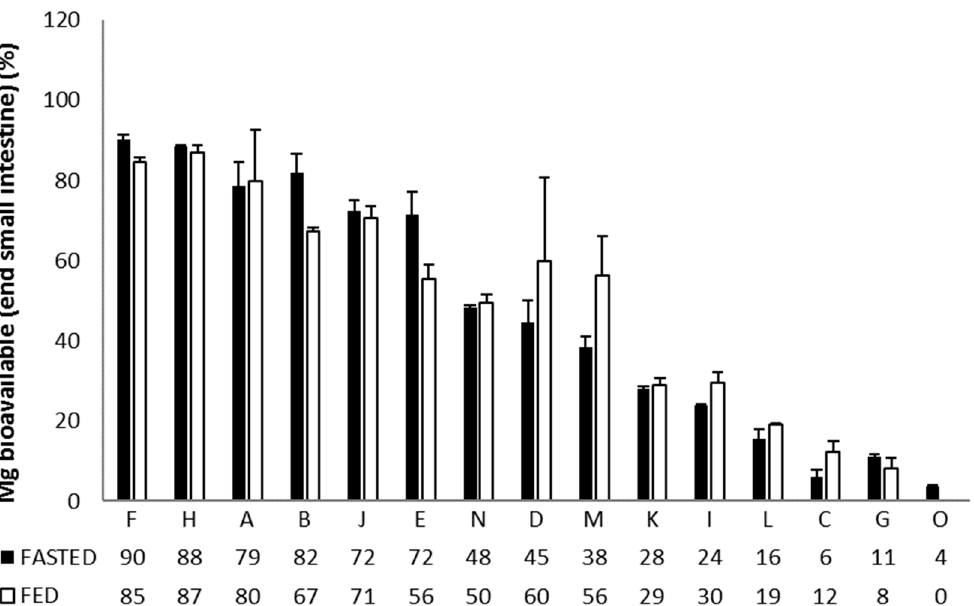
Figure 2. Relative (%) Mg 2 + absorption during the small intestinal incubation upon simulated ingestion of 15 Mg-containing formulations under fasted and fed conditions. Data are shown as average ( n = 3) ± STDEV.